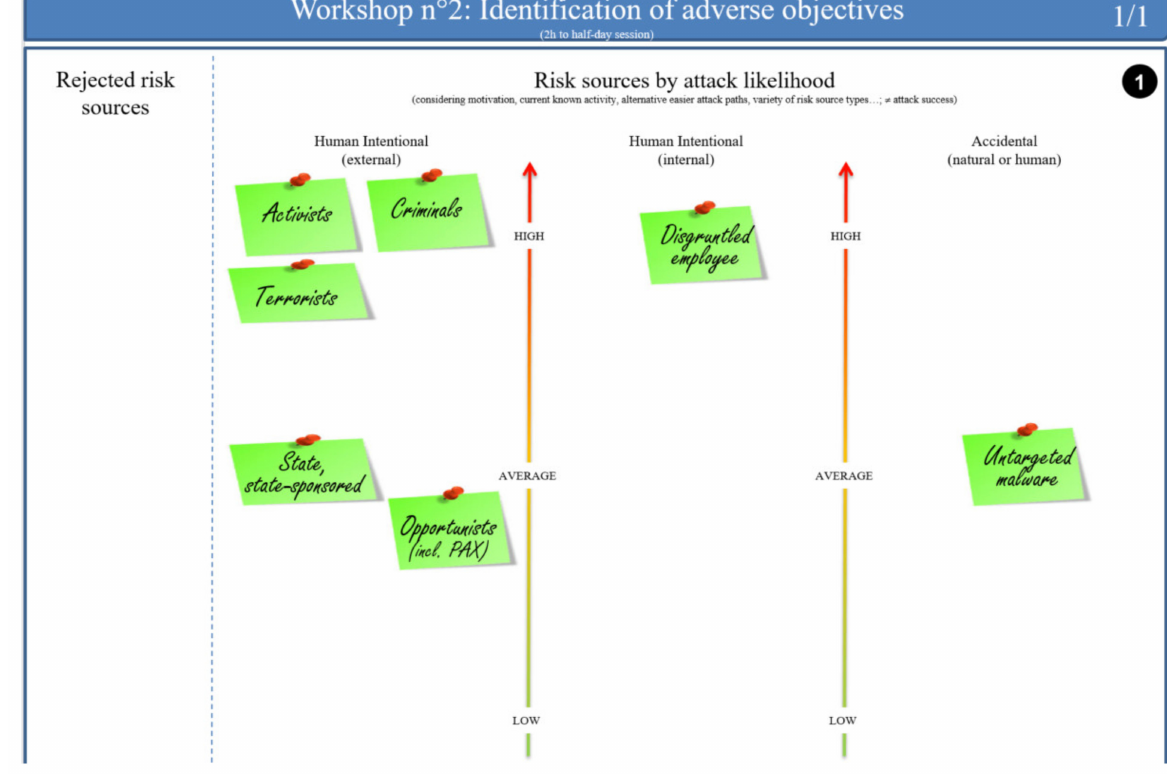
Figure 8. Naval use case—risk sources and their likelihood to try attacking.